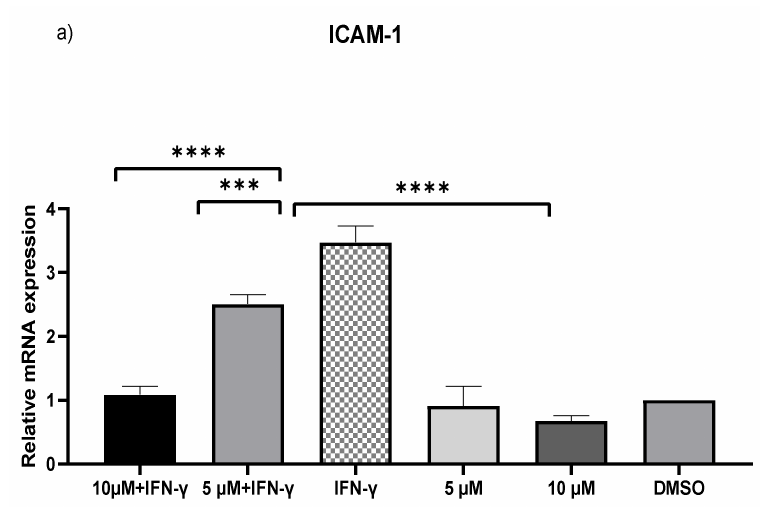
Figure 1. Kaempferol (5–100 µ M) does not influence macrophages cell viability. ( a ) Cell viability was assessed by calculating the LDH value in the medium from treated cells, ( b ) the crystal violet test on adherent cells was used to measure cell proliferation; ns—not significant. Mean ± SD of three separate